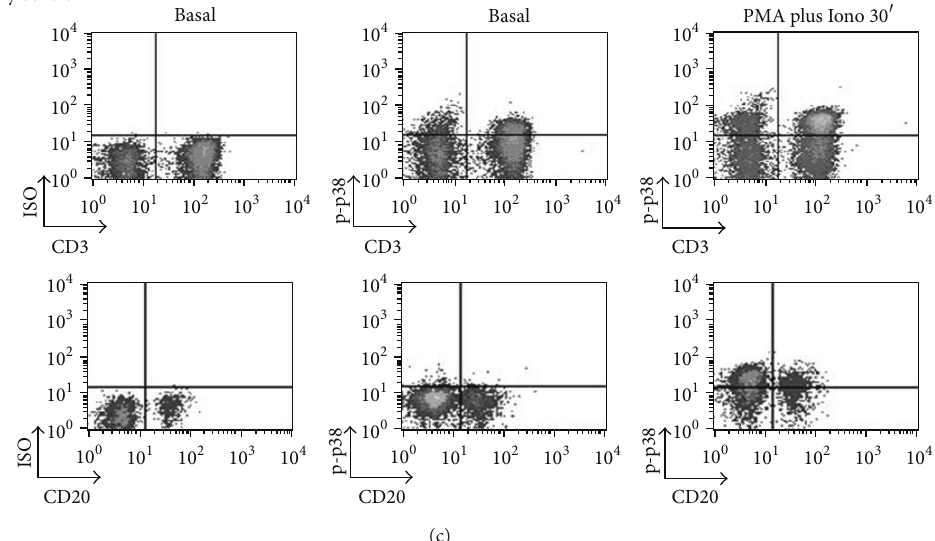
Figure 4: p-p38 detection in PBMCs subpopulations from normal controls and patients with autoimmune diseases. PBMCs from a representative healthy individual and patients with autoimmune disorders ((a), (b), and (c)) were left untreated or stimulated with PMA plus Ionomycin for 30min and stained with MoAbs against CD3, CD56, CD11c, CD20, and p-p38. Cell subsets were subgated based on surface epitope staining and plotted for p-p38. (a) A representative comparison of CD11c+ p-p38+ and CD3+ p-p38+ cells between a healthy control and a patient with systemic sclerosis is shown. (b) PBMCs stimulated with PMA plus Ionomycin or IL-12 plus IL-18. Shown here are percentages of CD56+ CD3 − p-p38+ cells from a RA patient using different stimuli (Gate R1). (c) Shown here are CD3+ p-p38+, CD3 − p-p38+, CD20+ p-p38+, and CD20 − p-p38+ cells after 30 min stimulation from another healthy donor.